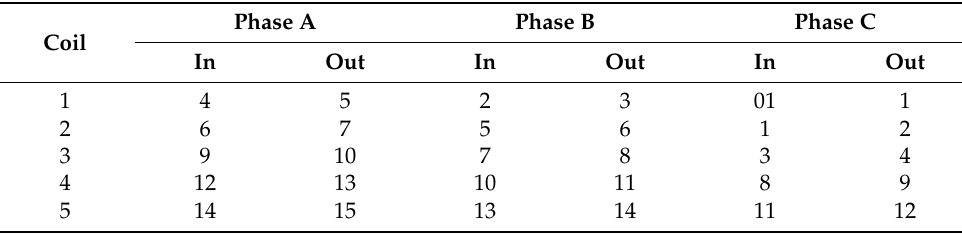
Table 2. Armature Winding Coil to Slot